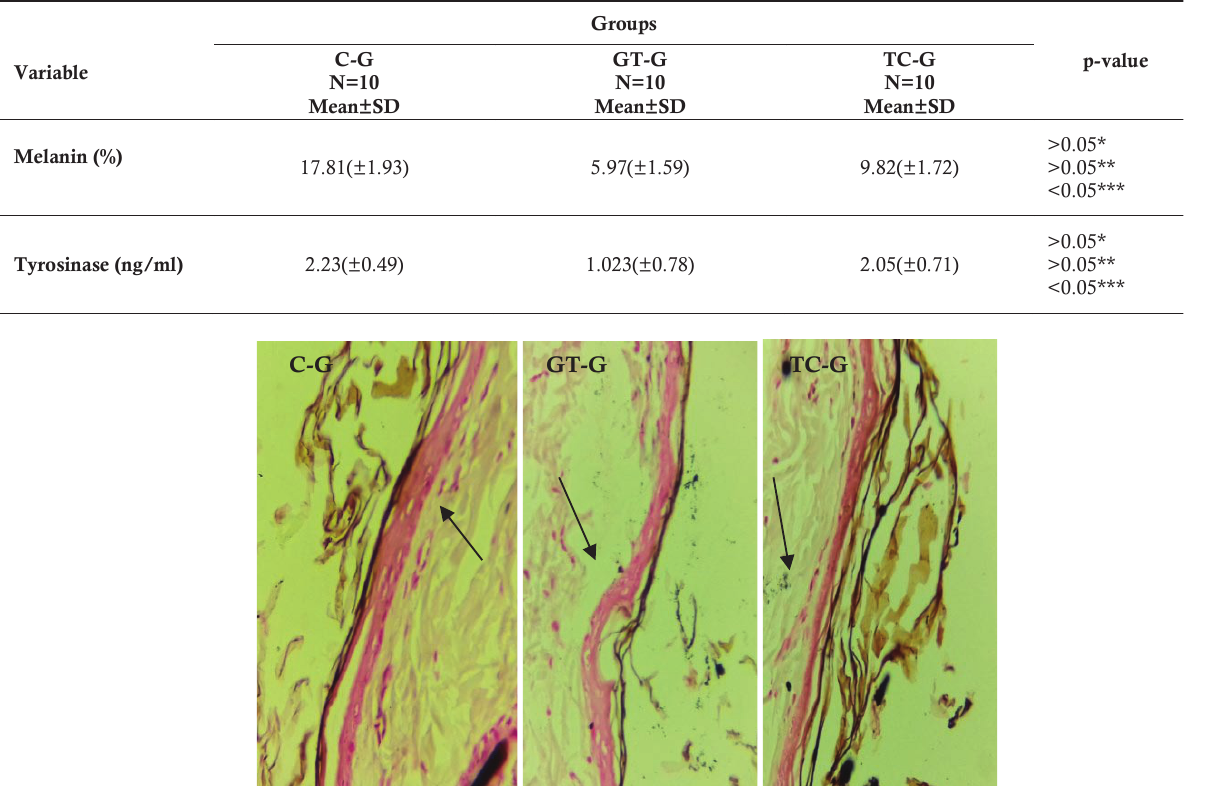
Figure 1 . Amount of melanin obtained from Masson-Fontana Dying methods on Skin Epidermis in each group .